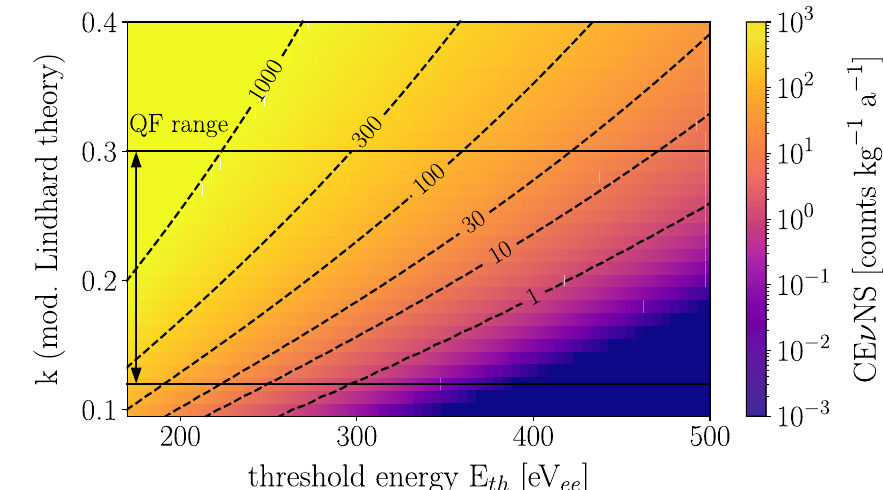
Fig. 1 Expected CE ν NS signal rate in Conus detectors at 17.1m distance from the reactor core with maximum thermal power P th of 3.9GW: the signal rate is depicted as function of (i) the lower bound of the region of interest and thus the energy threshold, and (ii) the experimentally not well known quenching factor (QF). Within the modified Lindhard theory, QF is described by the k parameter. The black horizontal lines confine the range of measured QF values reported in